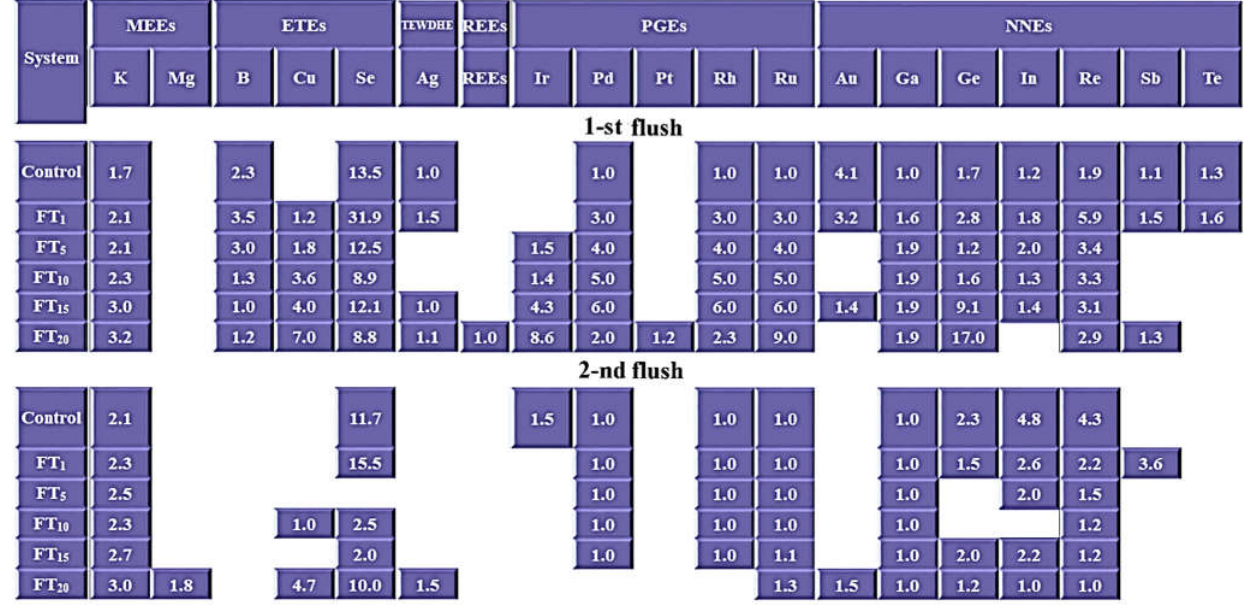
Figure 5. Bioaccumulation factor values for elements in fruit bodies collected from particular treat- ments.